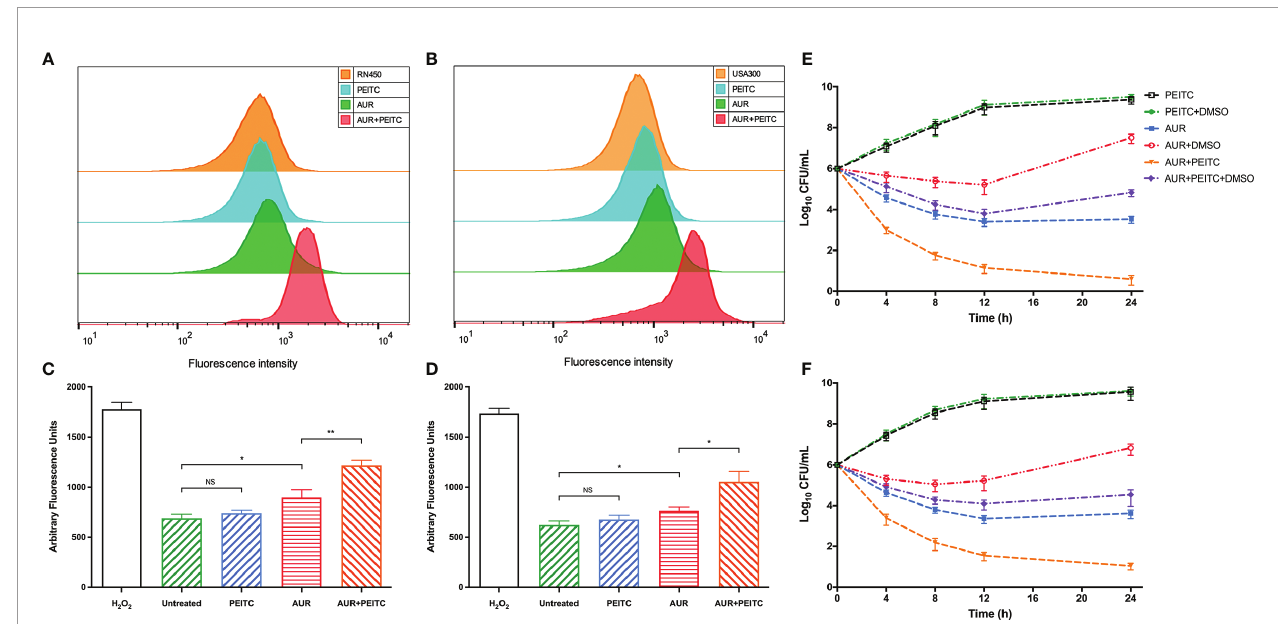
FIGURE 5 | Role of ROS in mediating AUR combined with PEITC induced lethality of S. aureus . (A) S. aureus RN450 and (B) MRSA USA300 were incubated with 10 mM carboxy-H2DCFDA for 10 min before observation. Controls, no treatment at 4 h. (C) S. aureus RN450 and (D) MRSA USA300 were untreated or treated with 0.15% H 2 O 2 , 4× MIC aurano fi n (AUR), 1× MIC phenethyl isothiocyanate (PEITC), or in combination for 4 h. 3 ’ -(p-hydroxyphenyl) fl uorescein (HPF) was added after treatment, and the fl uorescence was measured (490/515 nm). *P < 0.05; **P < 0.01; NS, no signi fi cance. (E, F) DMSO (5%) was added to diminish ROS levels. Combination-induced killing was decreased in the presence of DMSO for (E) S. aureus RN450 (P< 0.01) and (F) MRSA USA300 (P< 0.01) compared with no DMSO at 24 h. All panels show representative results from at least three independent experiments; error bars represent standard errors of the means.